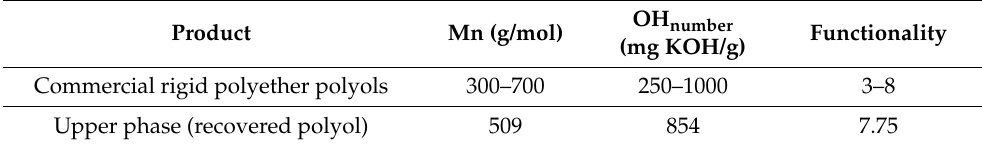
Table 3. Properties of recovered polyol and of commercial rigid polyether